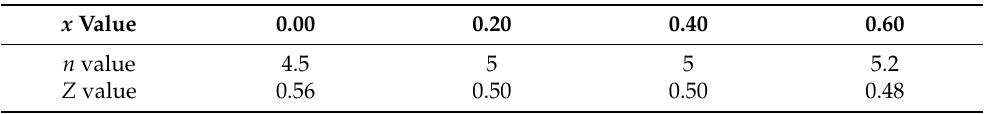
Table 1. Miniaturisation factor ( n , refractive index) and relative impedance ( Z ) of CO (2) Z ferrites corresponding to various x values.